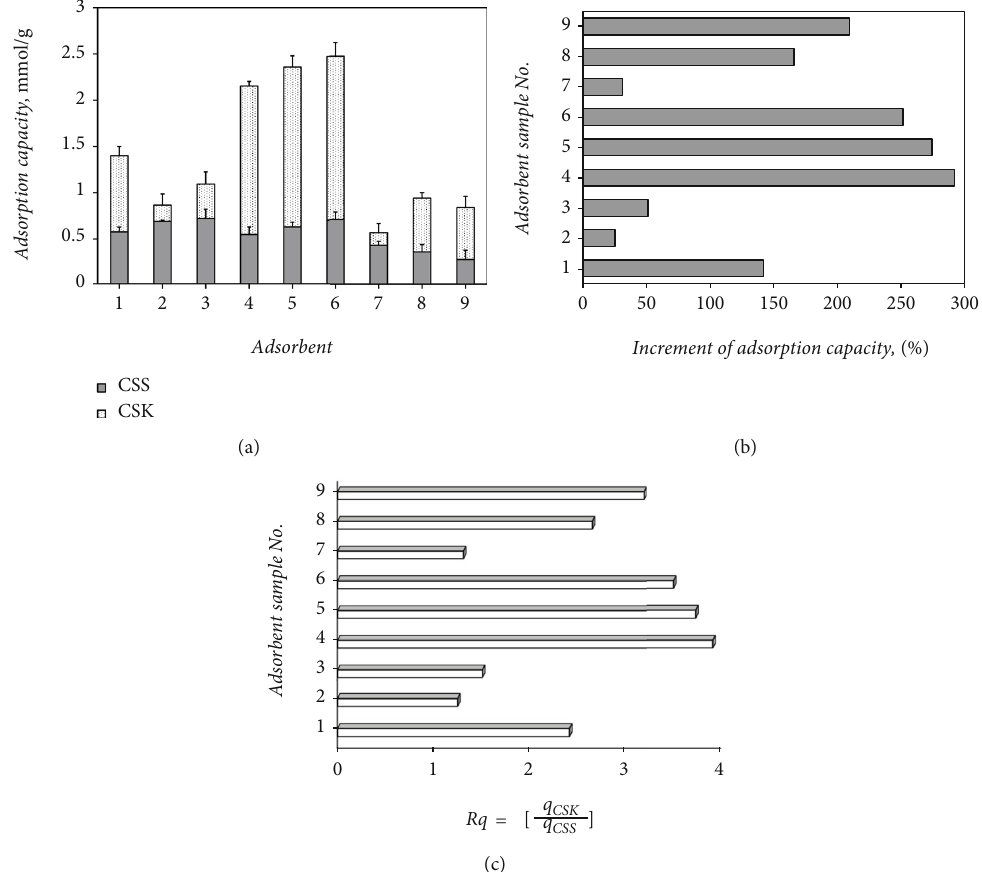
Figure 1: Performance of CSS and CSK adsorbents for itaconic acid separation from the aqueous solution at pH3 and temperature of 30 °